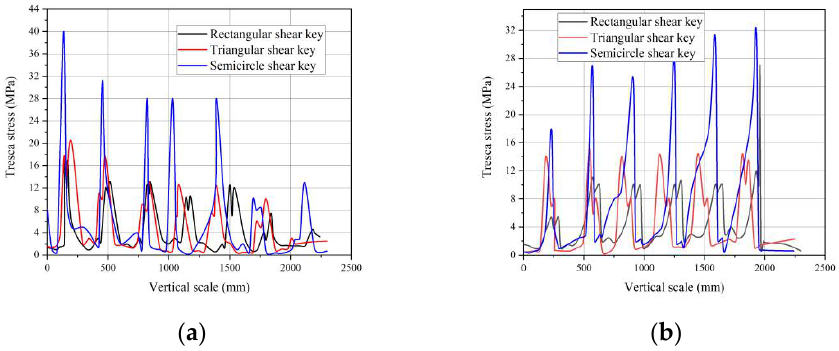
Figure 9. Tresca stresses axial distribution in grout along the internal and and external steel walls. ( a ) Stresses close to internal wall. ( b ) Stresses close to external wall. The maximum Tresca stresses are 27.09 MPa, 20.05 MPa and 40.38 MPa for the rectan-